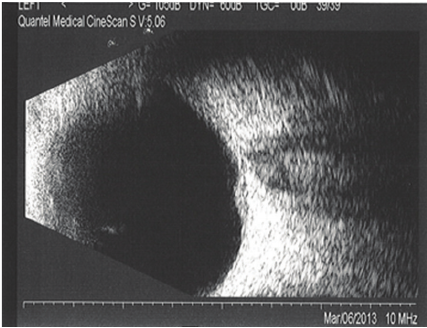
Figure 2: At diagnosis, B-scan ultrasound showed an elevated choroidal lesion with moderate internal reflectivity in the left eye.